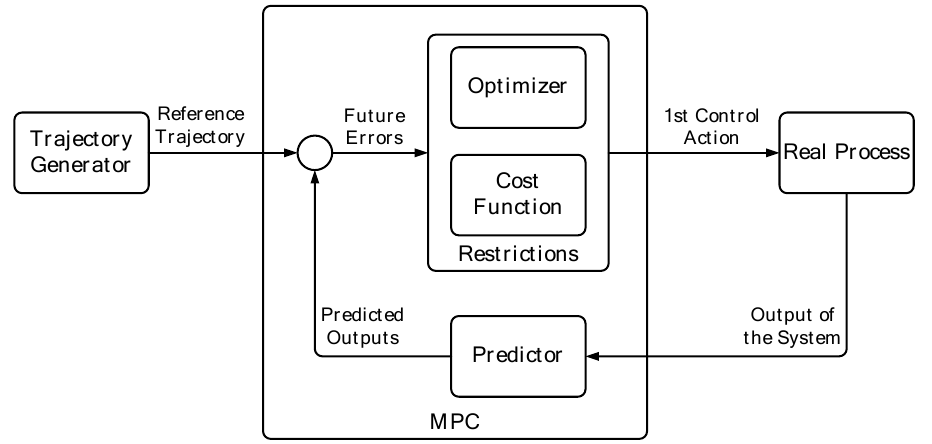
Figure 2. The concept of a receding horizon.